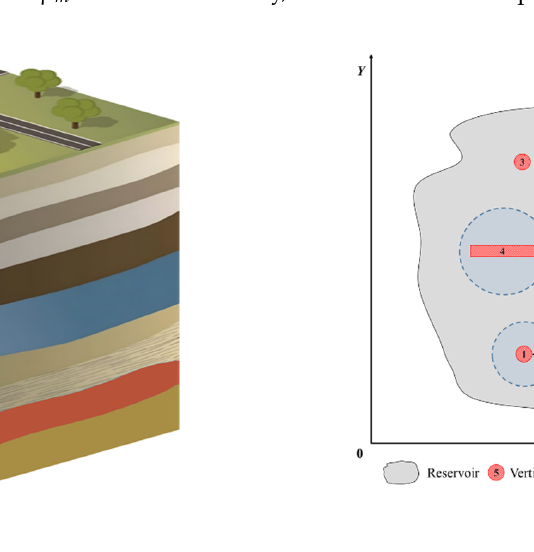
Figure 2. Physical model of UGS: ( a ) schematic diagram of gas reservoir − type underground natural gas storage (modified from Geostock [48]); ( b ) the horizontal and vertical wells with heterogeneous features in underground natural gas storage.